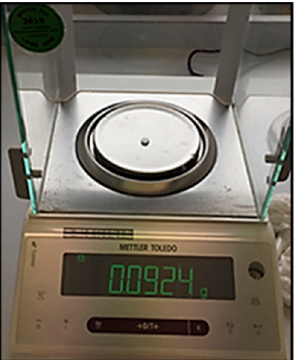
Figure 4. Mass determination using sensitive balance.